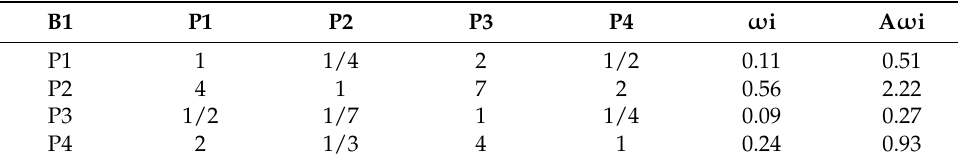
Table 7. B1-P comparison matrix.